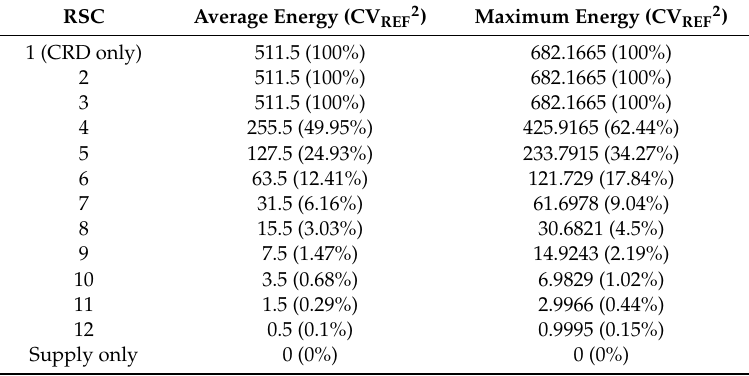
Table 1. Switching energy for the CRD according to the RSC.